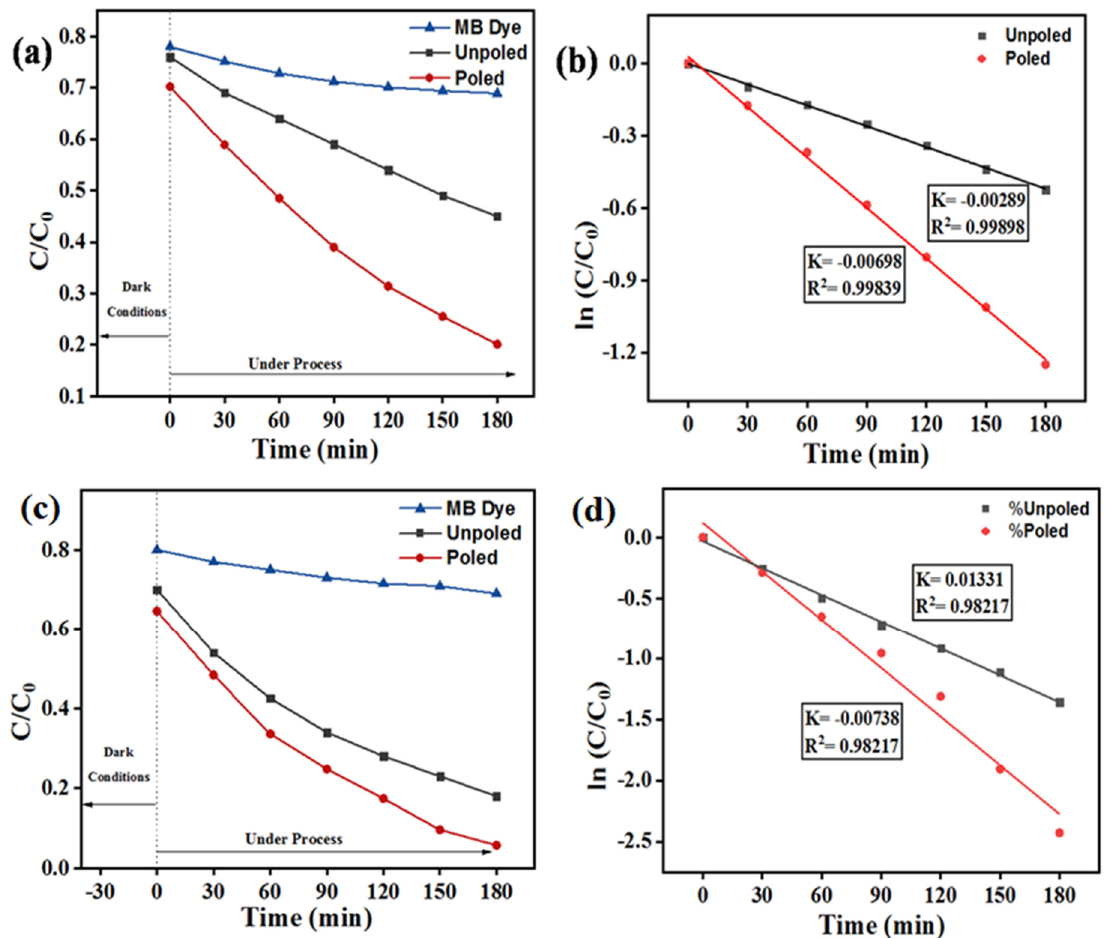
Figure 8. ( a ) % degradation of MB dye after 3 h using 0.1 g of unpoled and poled BST ‒ BZT powder through piezocatalysis process, ( b ) kinetic parameter of MB dye using 0.1 g of unpoled and poled BST ‒ BZT powder in piezocatalysis process, ( c ) % degradation of MB dye after 3 h using 0.1 g of unpoled and poled BST ‒ BZT powder through piezo-photocatalysis process, and ( d ) kinetic parameter of MB dye using 0.1 g of unpoled and poled BST ‒ BZT powder in piezo-photocatalysis process.